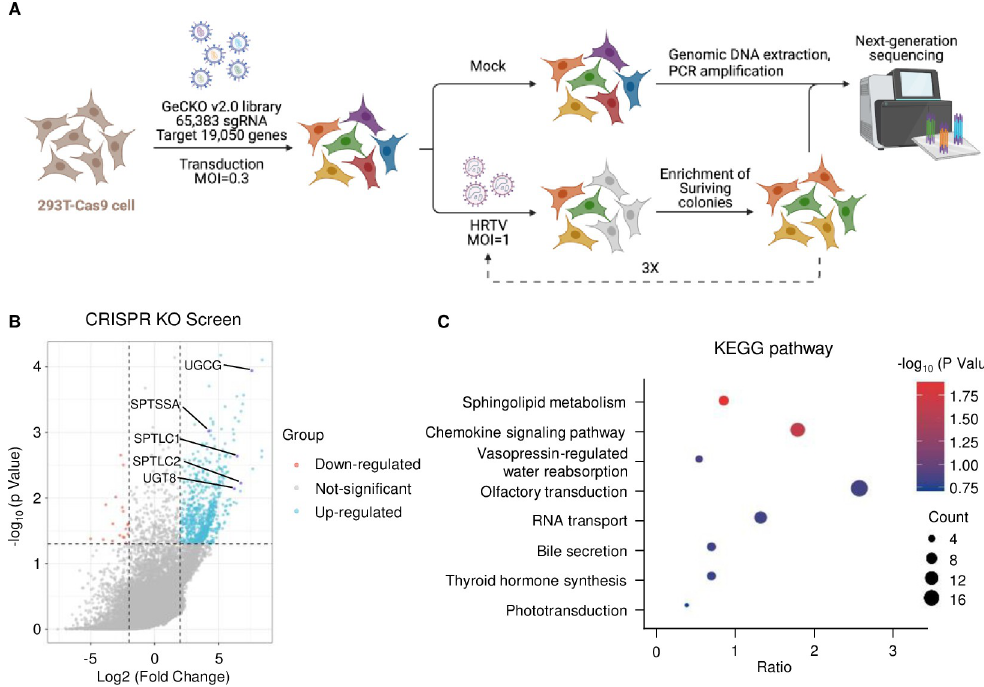
Fig 1. Genome-wide CRISPR screen identifies HRTV entry factors. A. Schematic of genome-wide CRISPR/Cas9 KO screen in 293T cells. Figure created with BioRender.com. B. Volcano plot analysis of the CRISPR/Cas9 KO screen results. Each dot represents a unique gene identified from sequencing results. The labeled genes are involved in the glycosphingolipid biosynthesis pathway. C. Bubble plot showing the pathway analysis of the statistically enriched genes in the screen. Bubble size and color reflect the statistical significance and the number of genes enriched in the relevant